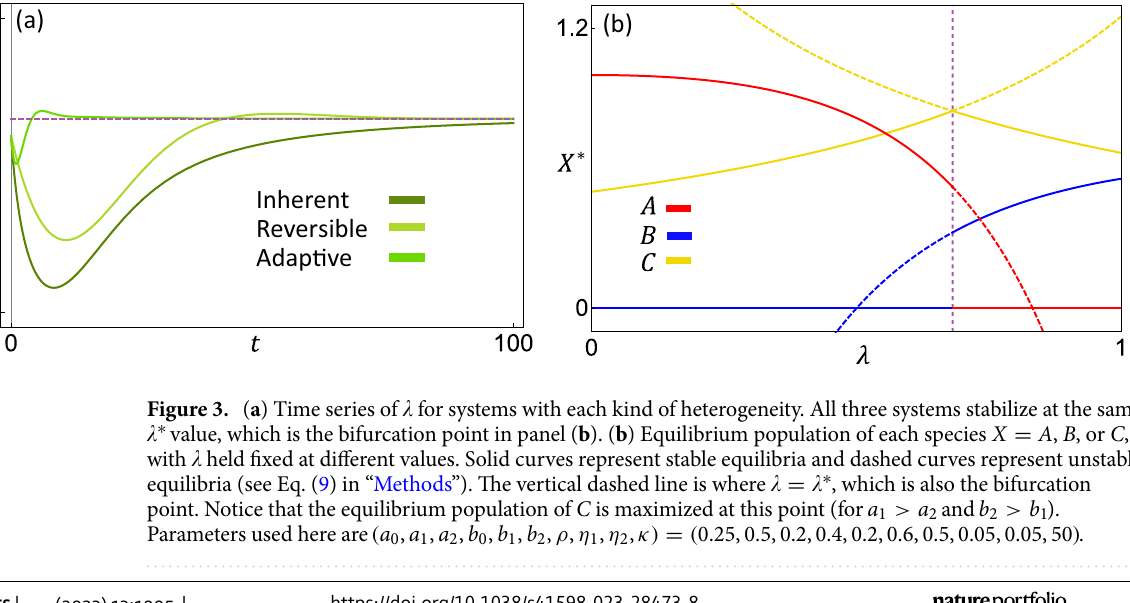
Here, a i and b i are the (rescaled) feeding rates of the predators on the prey type C i ; a 0 and b 0 are the death rates of the predators as before; η 1 and η 2 are the exchange rates of the prey types (Table 1). The latter can be functions of other variables, representing different kinds of heterogeneous interactions that we study below. Notice that Eqs. (4a–4c) are equivalent to the homogeneous Eqs. (2a–2c) but with effective interaction strengths (cid:31) (Fig. 1c). (cid:31) ) a (cid:31) a (cid:31) ) b (cid:31) b a b 1 + 2 and 1 + 2 that both depend on the prey composition eff = ( 1 − eff = ( 1 − The variable (cid:31) can be considered an internal degree of freedom within the C population. In all of the models we study below, (cid:31) dynamically stabilizes to a special value (cid:31) ∗ (a bifurcation point), as shown in Fig. 3a. Accord- ingly, a new equilibrium point P N appears (on the line L in Fig. 2), at which all three species coexist. For com- parison, Fig. 3b shows the equilibrium points if (cid:31) is held fixed at any other values, which all result in the exclusion of one of the predators. Thus, heterogeneous interactions give rise to a new coexistence phase (see Fig. 4 below) by bringing the prey composition (cid:31) to the value (cid:31) ∗ , instead of having to fine-tune the interaction strengths. The exact conditions for this new equilibrium to be stable are detailed in “Methods”.